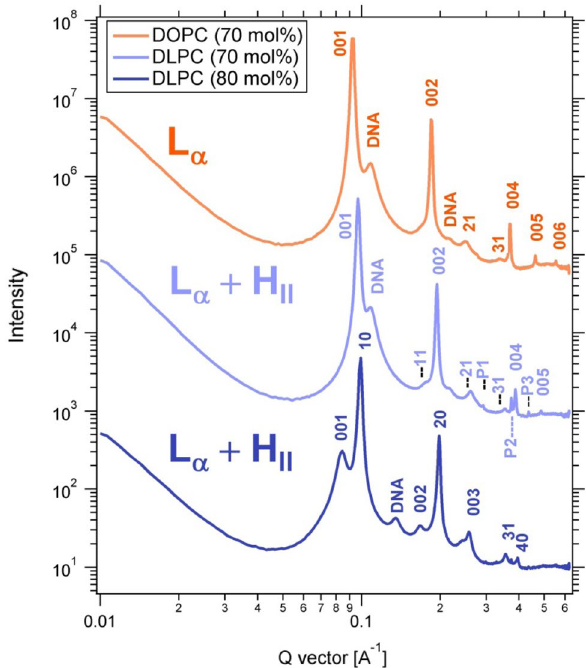
Figure 5. X-ray scattering profiles of CL–DNA complexes prepared from PTX-loaded CLs with high contents of DOPC or DLinPC, revealing their self-assembled structures. Peak assignments shown are for L α C (00L), H II C (HK), DNA–DNA interaxial spacing in the L α C phase (DNA), and crystallized PTX (P1, P2, P3). The CLs were composed of 70 or 80 mol% neutral lipid (DOPC or DLinPC), 2 mol% PTX, and the remainder DOTAP and were complexed with calf thymus DNA at a 1:1 charge ratio.